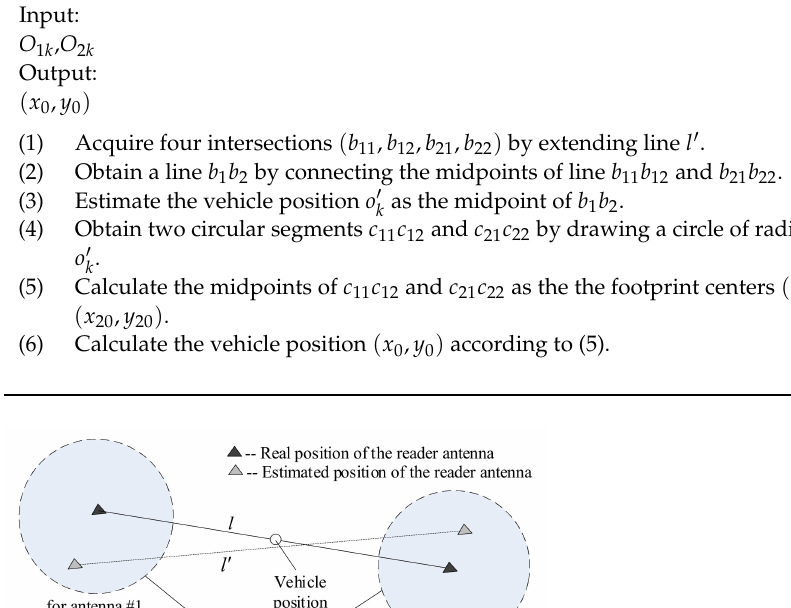
Algorithm 2 Joint rectification algorithm while both antennas detect enough tags.